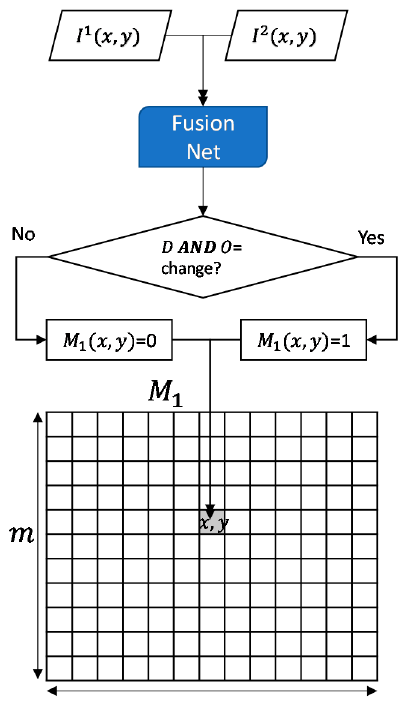
Figure 4. First prediction flowchart.